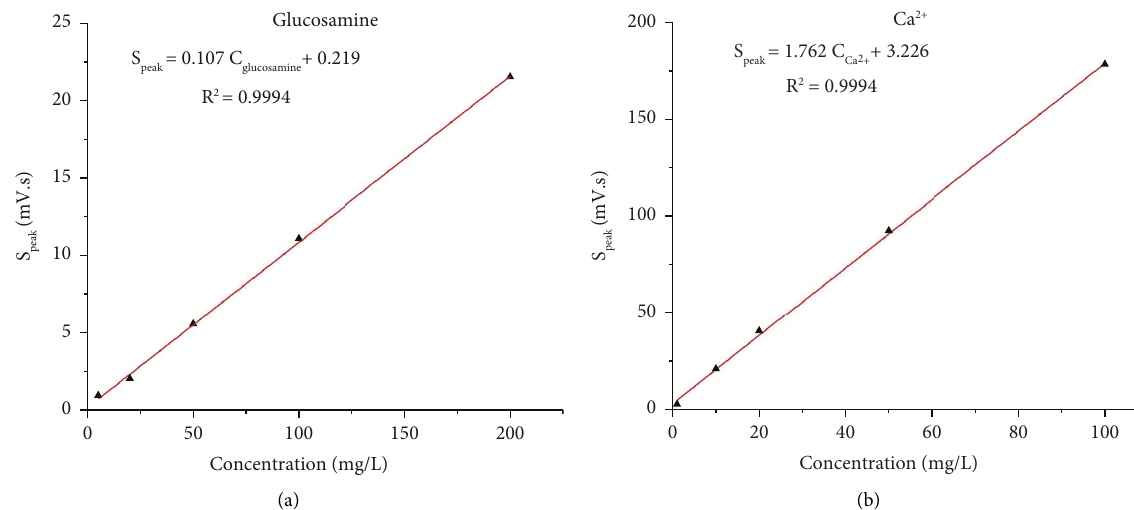
Figure 5: Calibration curves of glucosamine and calcium. BGE conditions: 10mM Tris/Ace electrolyte solution, pH of 5.0, separation voltage of +20kV, sample injection time of 30s, sample injection height of 25